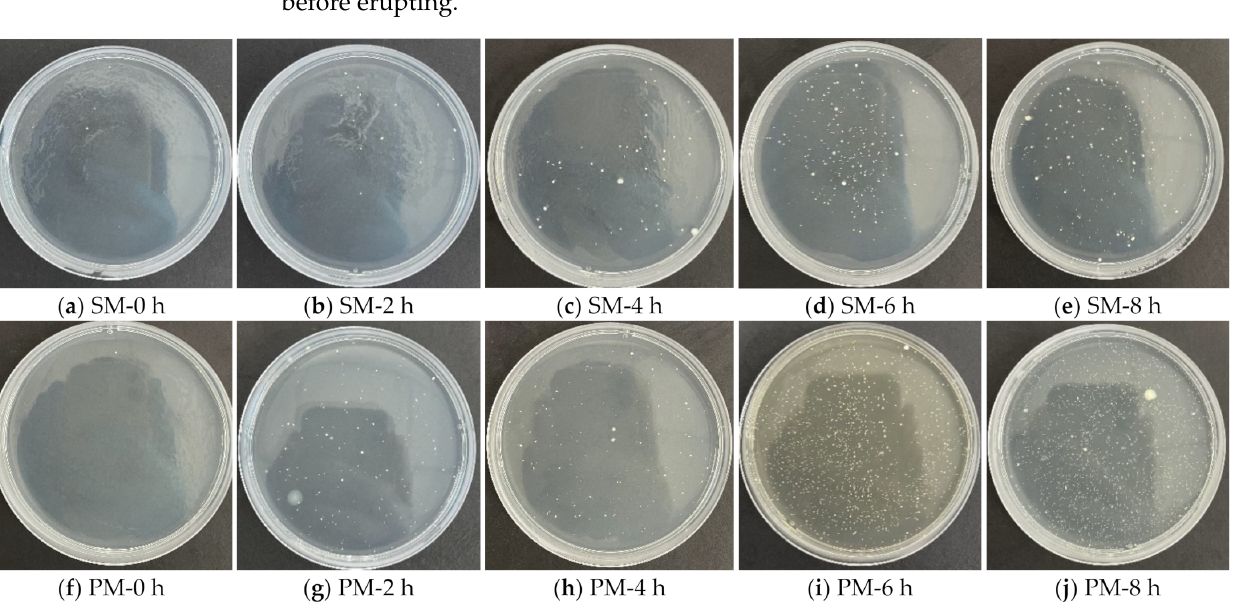
Figure 6. Bacterial colony development after using SM and PM for different lengths of